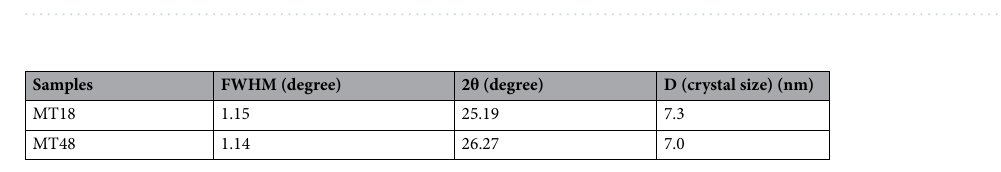
Figure 2. Characterization schemes of the prepared samples ( A ): Raman analysis, ( B ): FTIR analysis, ( C , D ): XRD of MT18, and MT48, respectively.